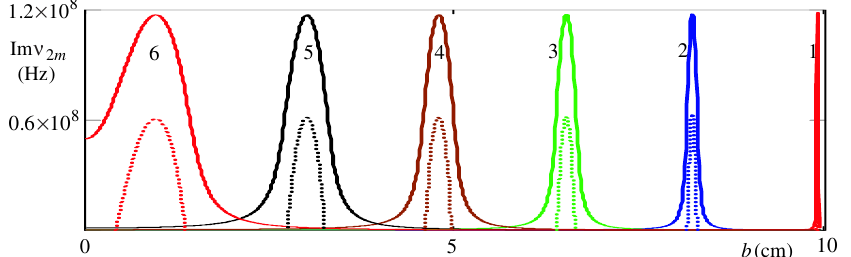
FIG. 5. (Color) Dependence of the imaginary parts of the mode frequencies on the channel radius for a (cid:4) 10 cm . Solid and dotted curves correspond to the cases of Im " (cid:4) 0 and Im " (cid:4) 0 : 02 accordingly. The mode number m of the corresponding amplified TM mode is indicated.